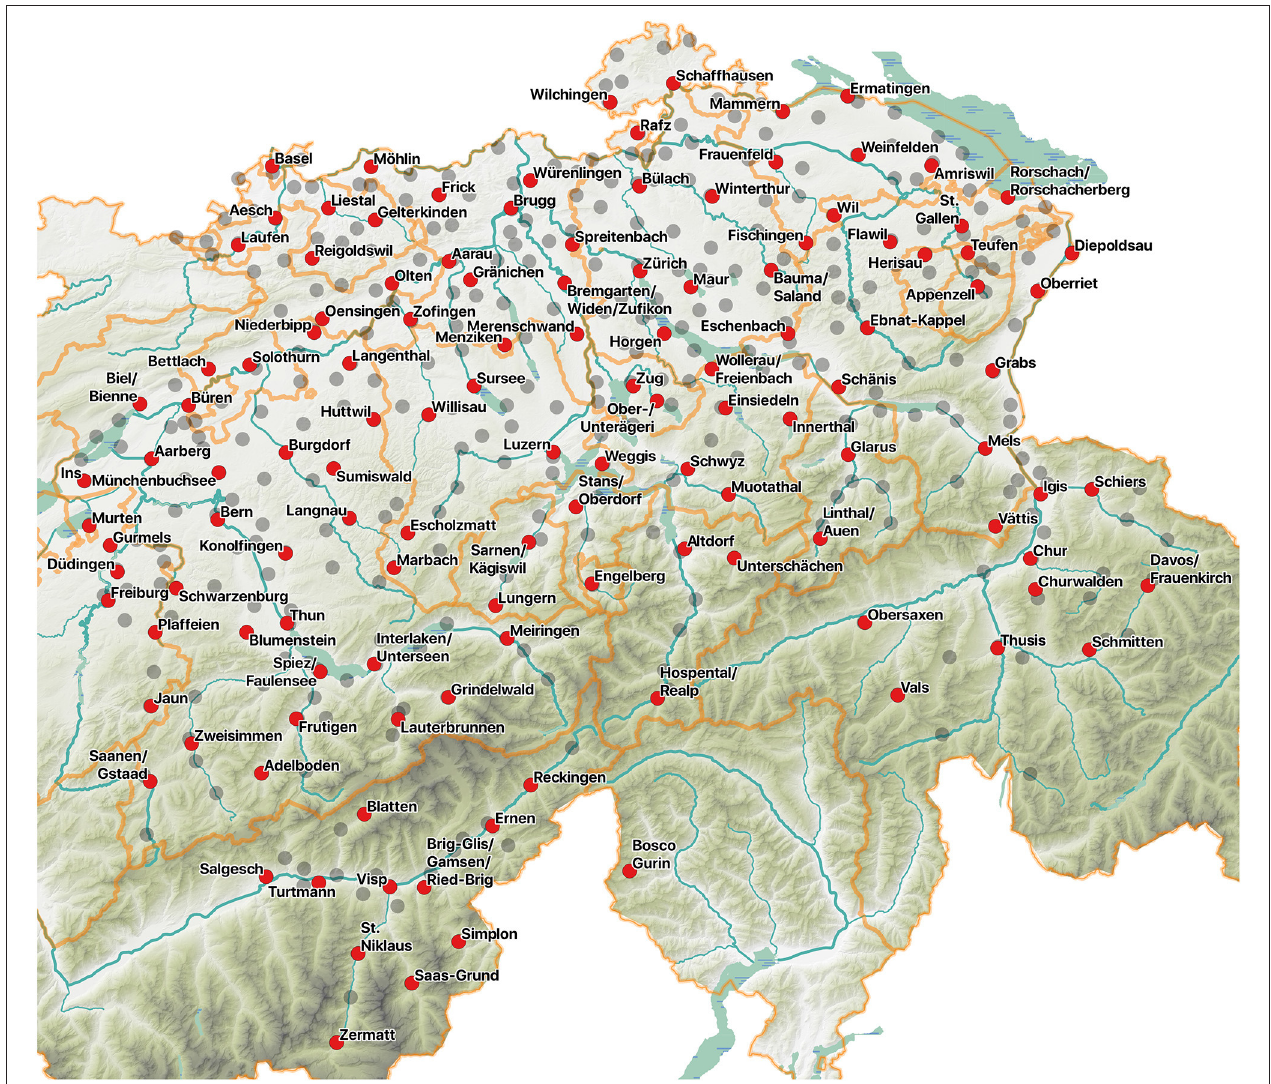
FIGURE 8 | The final selection of SDATS survey sites (in red with names), along with all SDS sites (gray). After the quantitative analysis and the qualitative revision, 125 sites are selected from the original